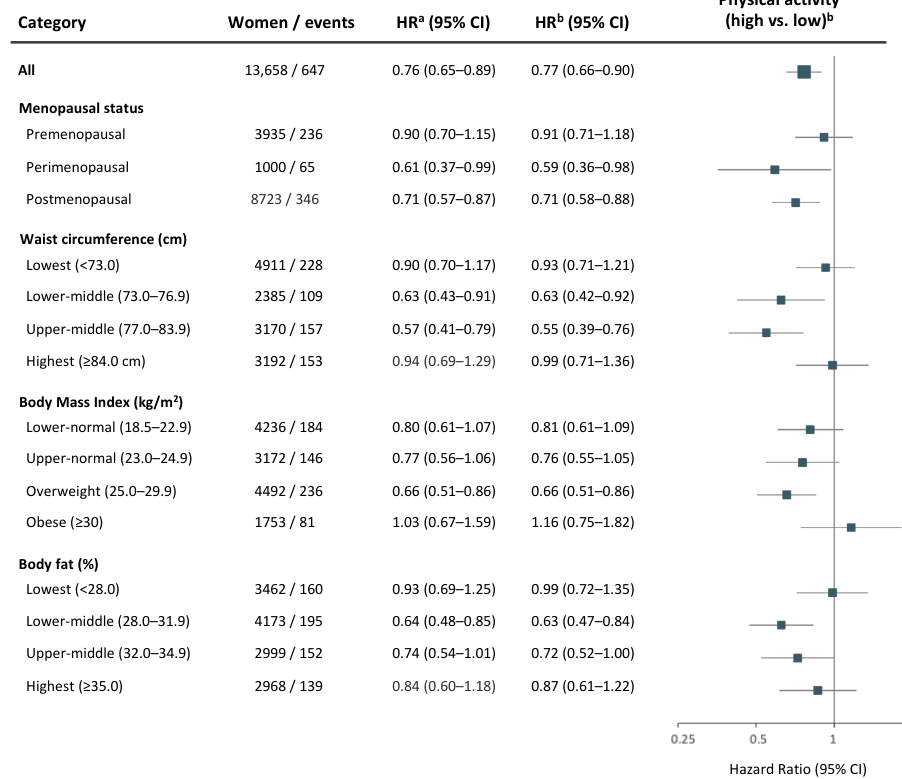
Figure 5. Physical activity and long-term (12+ years) risk of breast cancer. Age- and multivariable- adjusted hazard ratios (HR) with 95% CI for a high versus low level of physical activity among all women, and by menopausal status or body composition. Women and breast cancer events shown represent the numbers available in the multivariable model. The forest plot illustrates multivariable- adjusted HR with 95% CI. a Model adjusted for age at baseline. b Multivariable model adjusted for age at baseline, age at menarche, parity, age at first childbirth, oral contraceptive use, current hormone replacement therapy use, socioeconomic index, and alcohol consumption. Models for all women or stratified by body composition (waist circumference, BMI, or body fat percentage) were additionally adjusted for age at menopause.